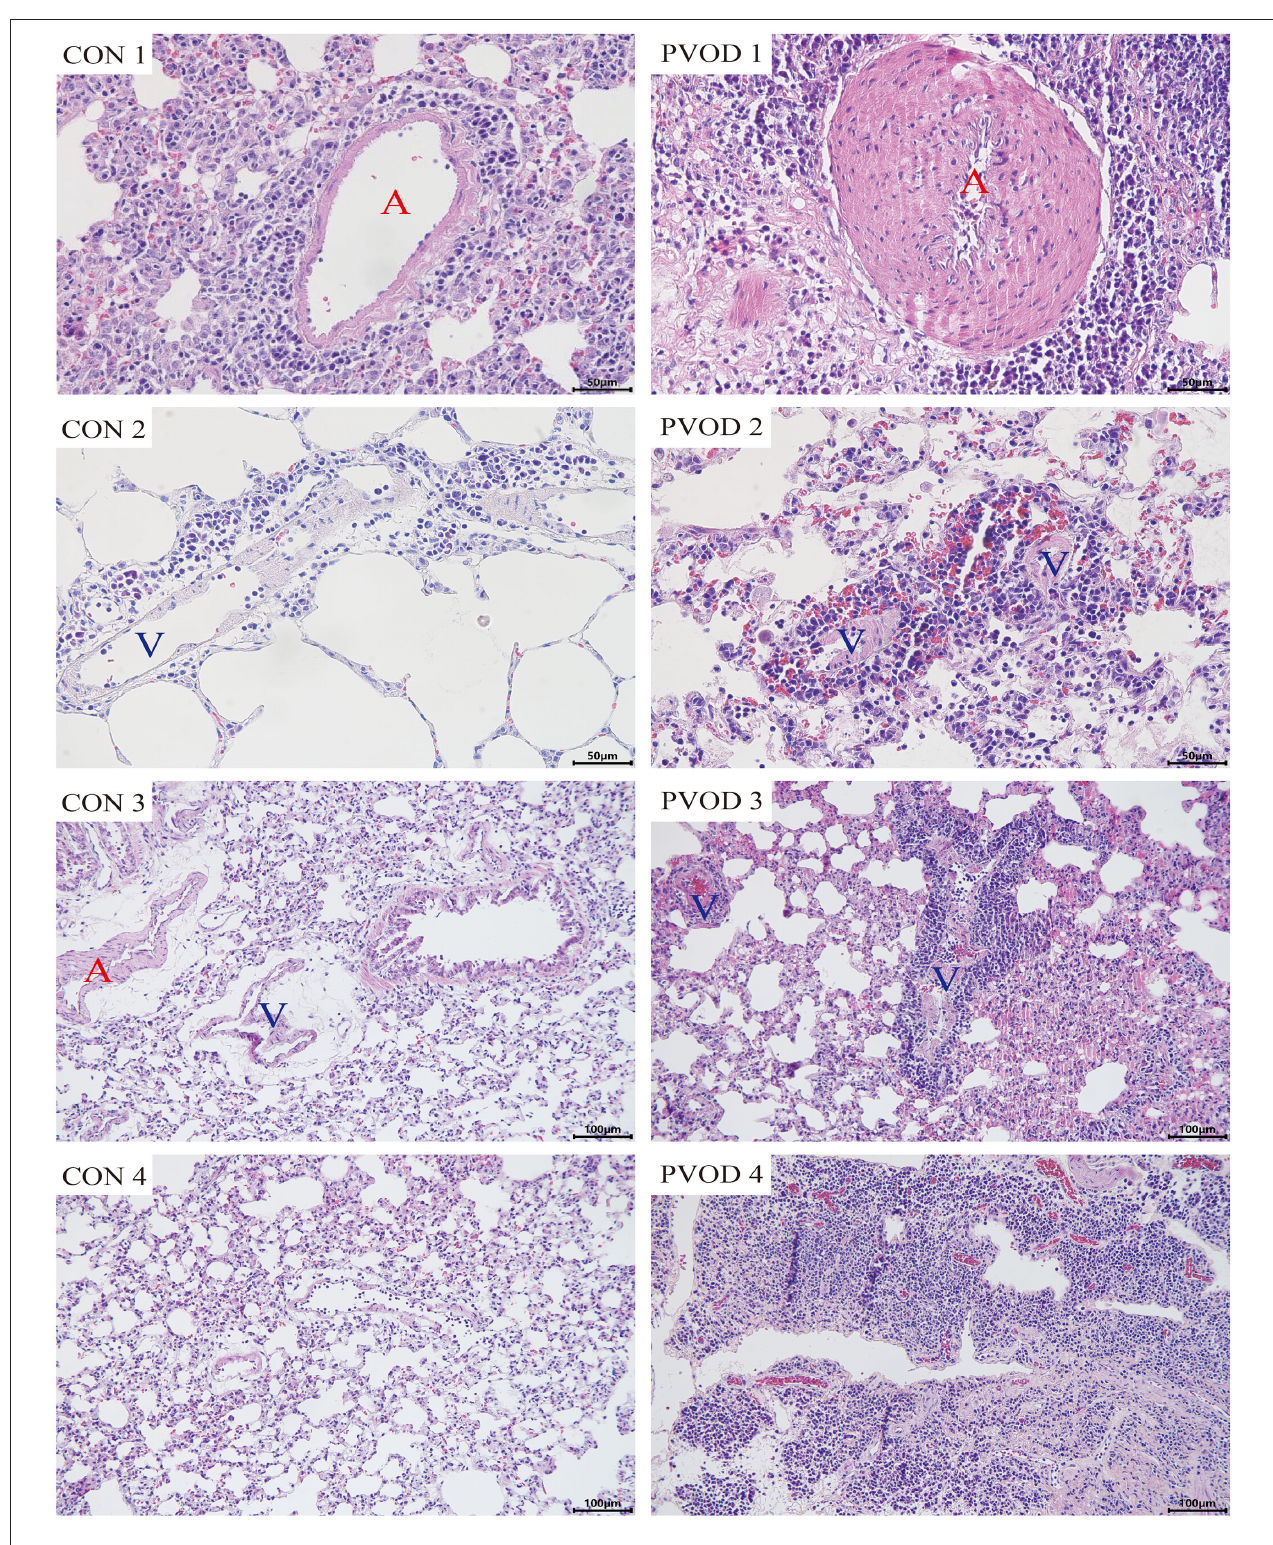
FIGURE 4 | The pathological of lung tissues in control and MMC-induced rat with PVOD with H&E stained. PVOD 1, pulmonary artery with medial hypertrophy/hyperplasia; PVOD 2, vasculitis of pulmonary capillary; PVOD 3, foci of pulmonary edema and capillaritis hemangiomatosis; PVOD 4, alveolar wall thickening. CON 1–4, control lungs; PVOD 1–4, MMC-induced lungs. CON 1–2 and PVOD 1–2: scale bar, 50 µ m; CON 3–4 and PVOD 3–4: scale bar, 100 µ m. The control group ( n = 4 rats) and the PVOD group ( n = 10 rats). A, artery; V, vein; MMC, mitomycin-C; PVOD, pulmonary veno-occlusive disease.